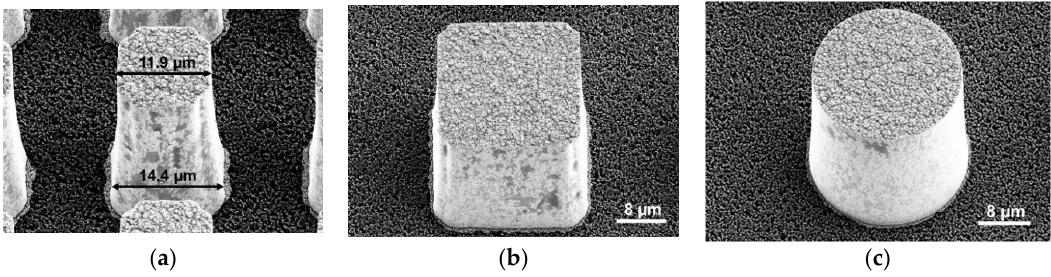
Figure 4. Close ‐ up SEM images of two ‐ dimensional X ‐ ray gratings of 28 μ m gold height: ( a ) the square grating of the 25 μ m period; ( b ) the square grating of the 50 μ m period; and ( c ) the round pillar of the 50 μ m period.